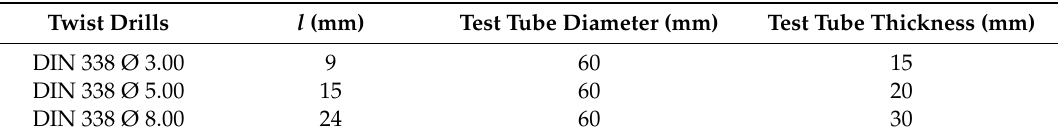
Table 5. The test tube